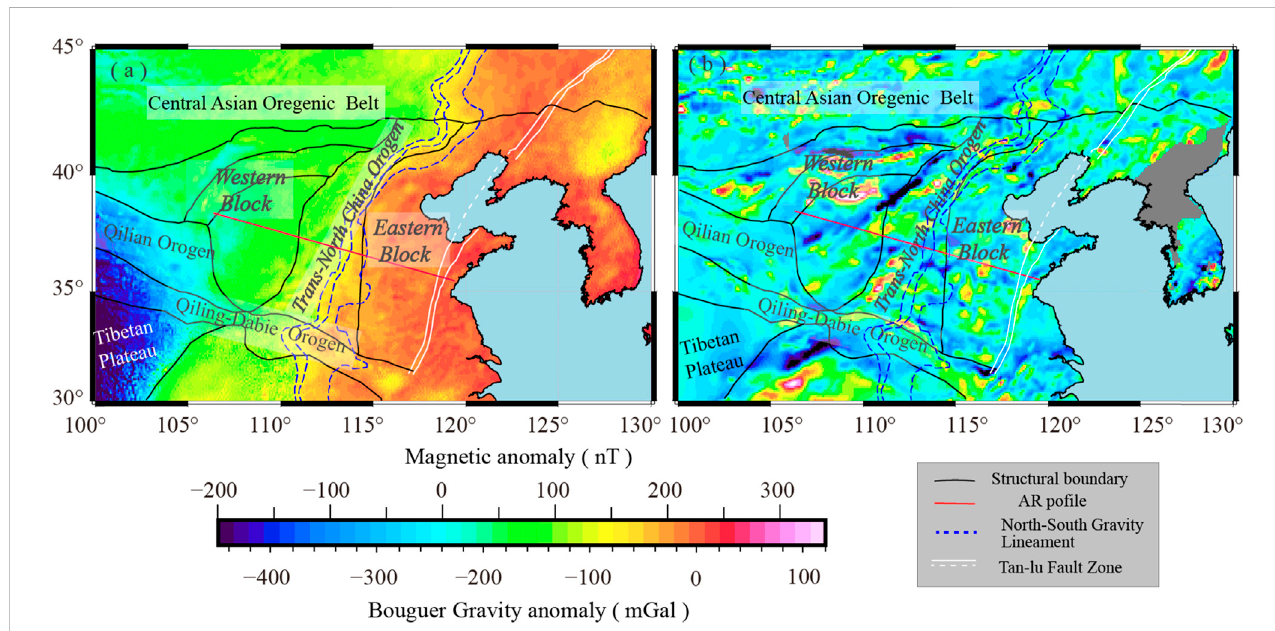
FIGURE 2 (A) The Bouguer gravity anomaly of the North China Craton and its adjacent areas based on data from EGM2008 after (Pavlis et al., 2012). (B) The magnetic anomaly of the North China Craton and its adjacent based on data from the World Digital Magnetic Anomaly Map project (Maus et al.,